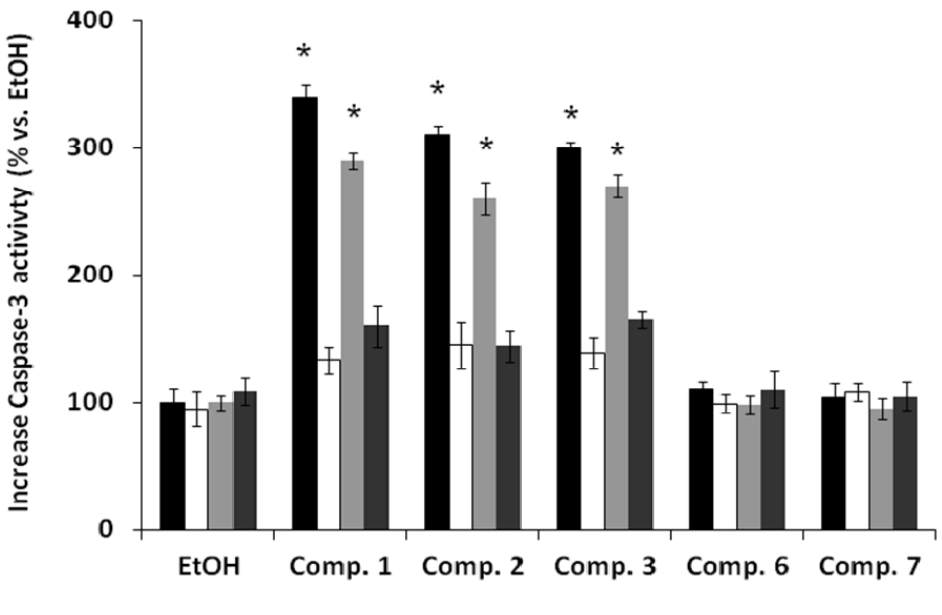
Figure 5. Effect of ent -labdanes on caspase3 activity of MDA-MB-231 (black or white columns) and DU-145 (light or dark gray columns) cells. Cells were pretreated with (white or dark gray columns) or without zVAD-fmk (black or light gray columns), a pan caspase inhibitor, and exposed to compounds 1 – 3 , 6 and 7 (25 µM) and incubated for 24 h. Values are mean ± S.D. ( n = 3). All data is reported as the percentage change in comparison with the vehicle-treated cells, which were arbitrarily assigned 100%. * p < 0.01, significantly different from the vehicle-treated cells (1% ethanol in medium, that is, compound concentration =